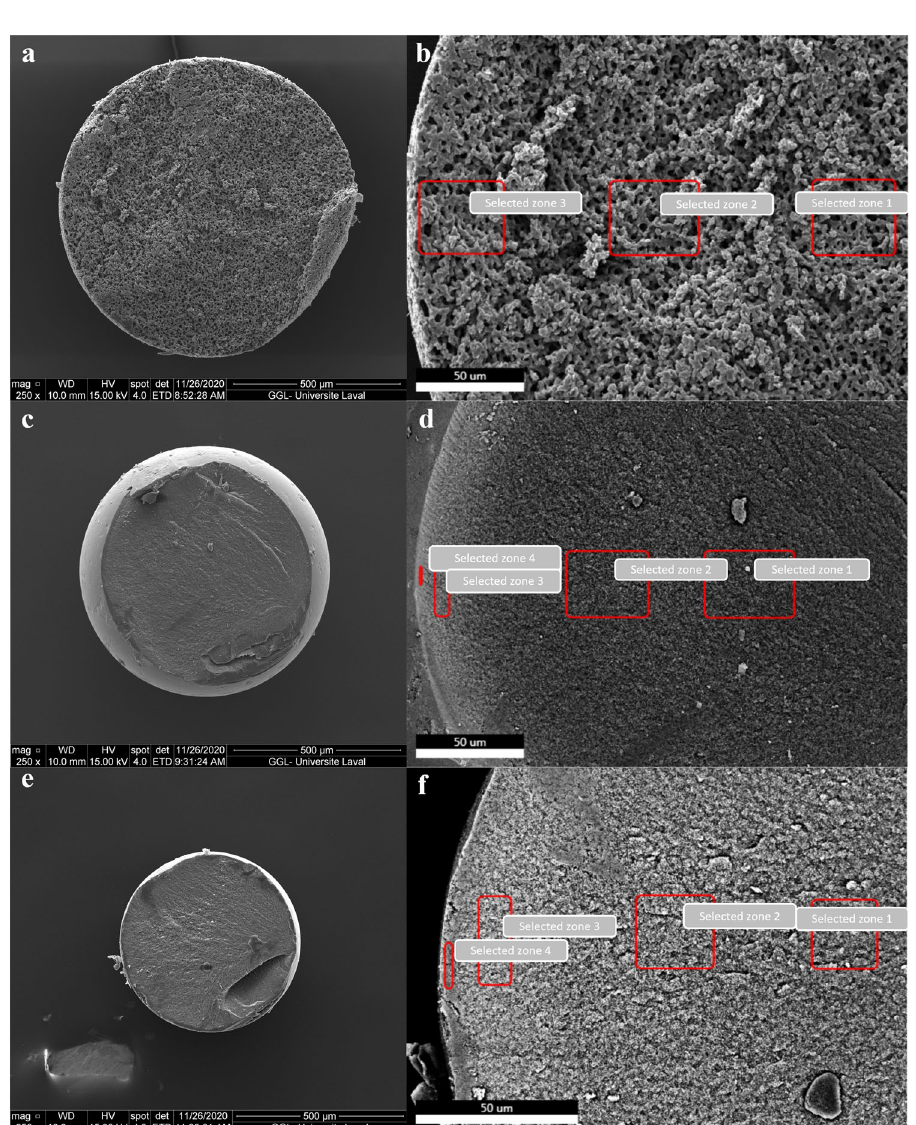
Fig. 2 SEM and EDS images of HAIX-Nano samples. a , b SBA-1 (SEM, EDS), c , d WBA-1 (SEM, EDS), e , f WBA-2 (SEM, EDS).